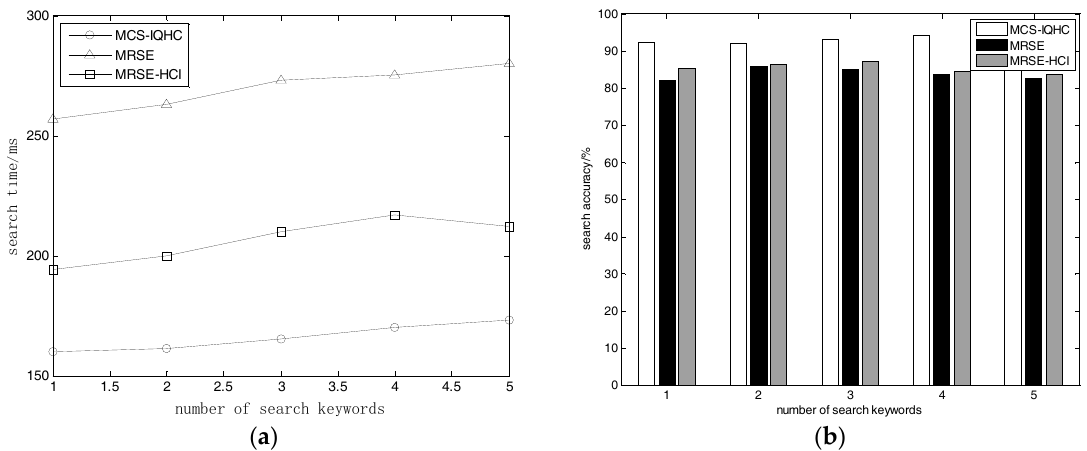
Figure 4. ( a ) Relationship between number of keywords and search time; ( b ) Relationship between number of keywords and search accuracy.